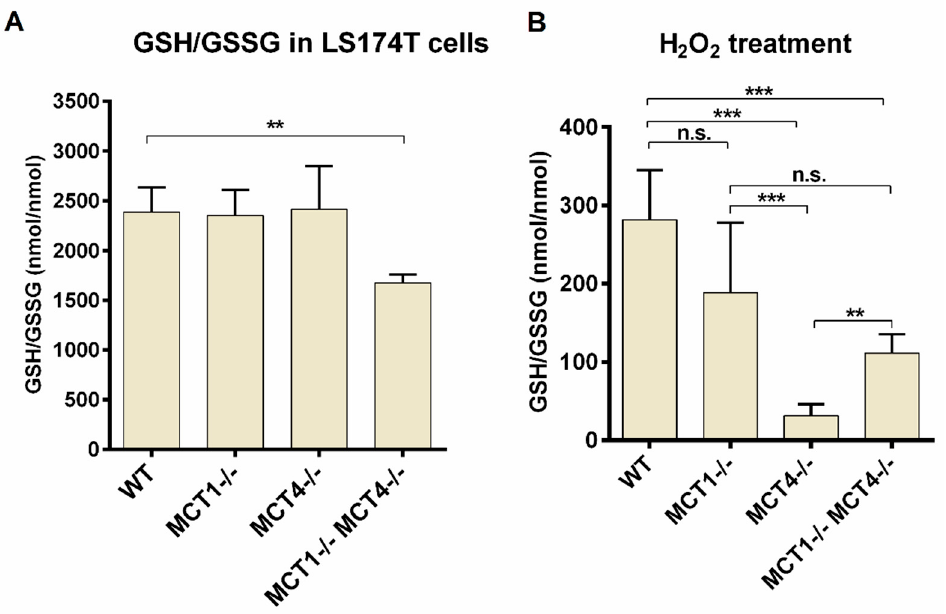
Figure 6. GSH / GSSG ratio in MCT -competent and MCT -deficient LS174T cells, respectively, in response to oxidative stress. Cells were ( A ) cultured under normal condition or ( B ) treated with 0.2 mM H 2 O 2 for 10 min, before they were washed with PBS containing 1 mM NEM. Treatment with H 2 O 2 decreases the ratio of GSH to GSSG in all cell lines. However, MCT4 − / − and double knockout cells are more sensitive to oxidative stress than MCT -competent and MCT1 -deficient cells. * p < 0.05, ** p < 0.01, *** p < 0.001, n.s., not significant, for further statistics see Supplementary Table S1. Detailed data presented in this figure were summarized in Supplementary Table S3.